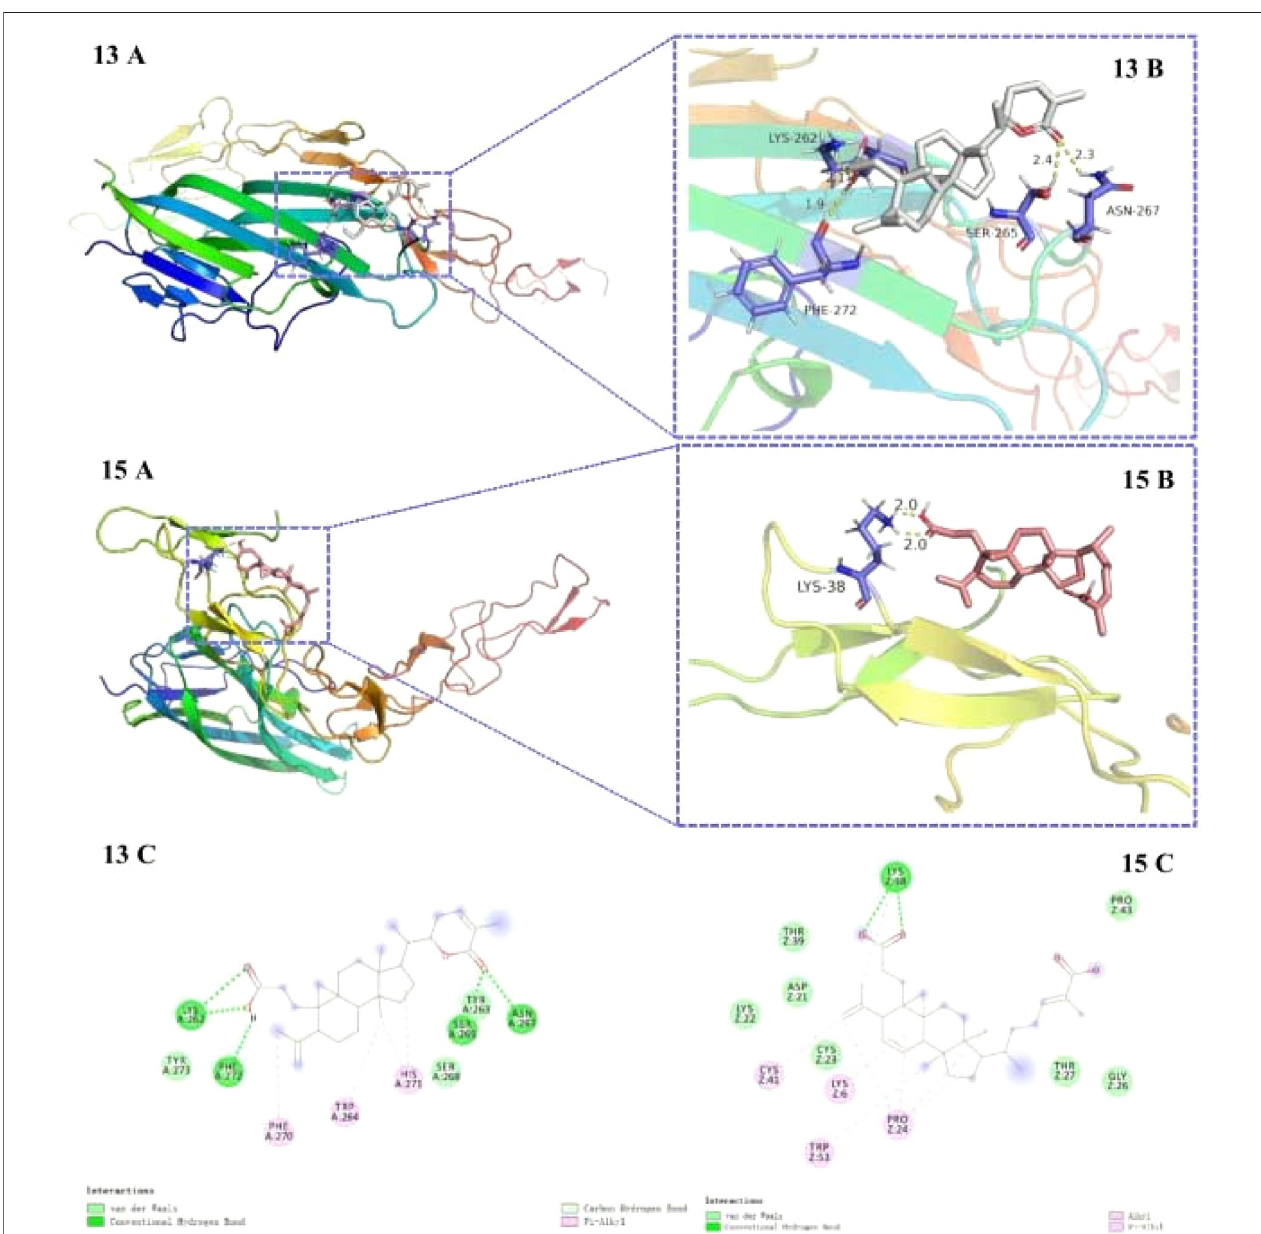
FIGURE 7 | Docking poses (A) and interactions (B, C) of compounds 13 and 15 at the binding site of RANKL (receptor activator of nuclear factor k-B ligand). Hydrogen bonds and hydrophobic interactions are represented by the green and pink lines, respectively (c)